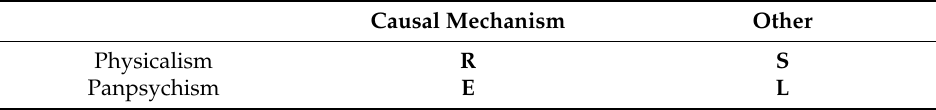
Table 1. Is chemistry relevant for consciousness studies? There are 3 possible answers (mechanistic reduction, supervenience, or emergence) that correspond to the relation of chemistry and consciousness in different ontological settings (physicalism and panpsychism). In some exotic models, one finds that there is even a loss of (proto-)consciousness at the level of molecules. For details see